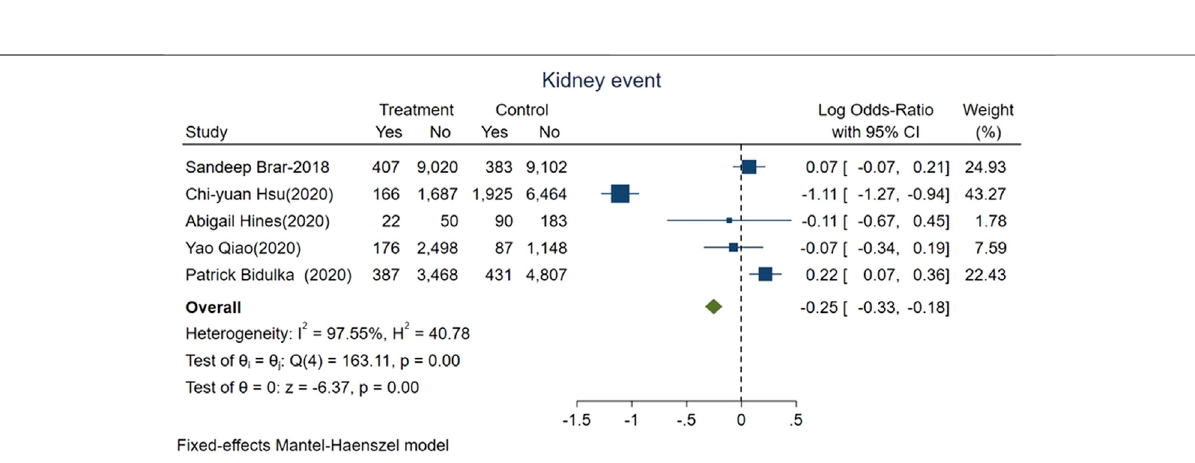
Frontiers in Pharmacology |